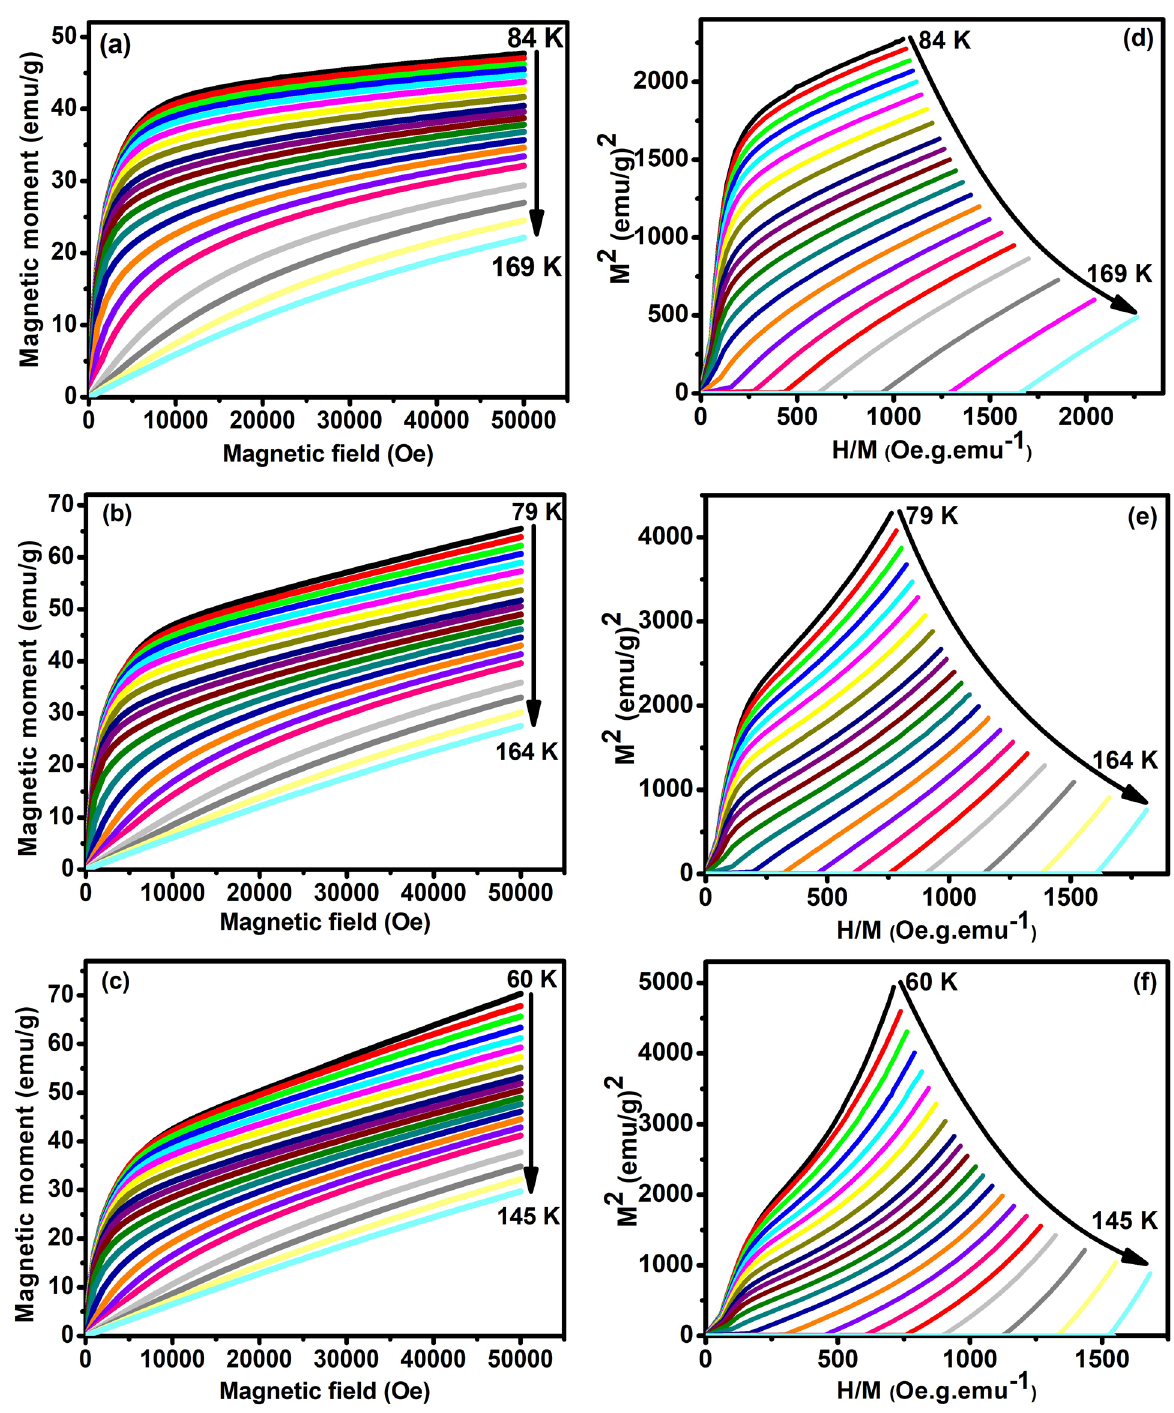
Figure 4. ( a – c ) Isothermal magnetization curves (MH) around T C ( d – f ) Arrott plot for ENMO, GNMO and TNMO samples. The positive slope of Arrott plots confirms second-order magnetic phase transition in studied